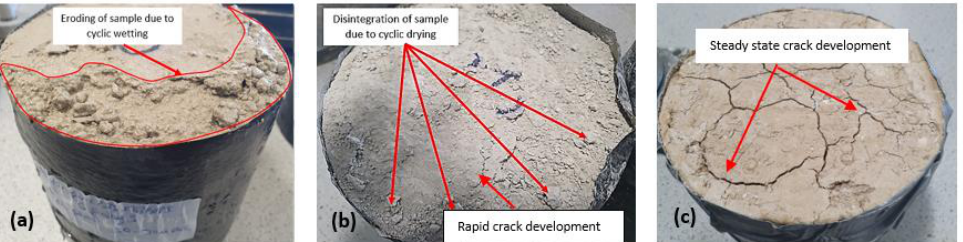
Figure 1. ( a ) Eroded subgrade sample due to cyclic wetting ( b ) Rapid crack development stage with loose particle following breakdown of interparticle bonds due to high temperature ( c ) Oven dry sample exhibiting steady-state crack development similar to a typical natural dry expansive sub-grade.